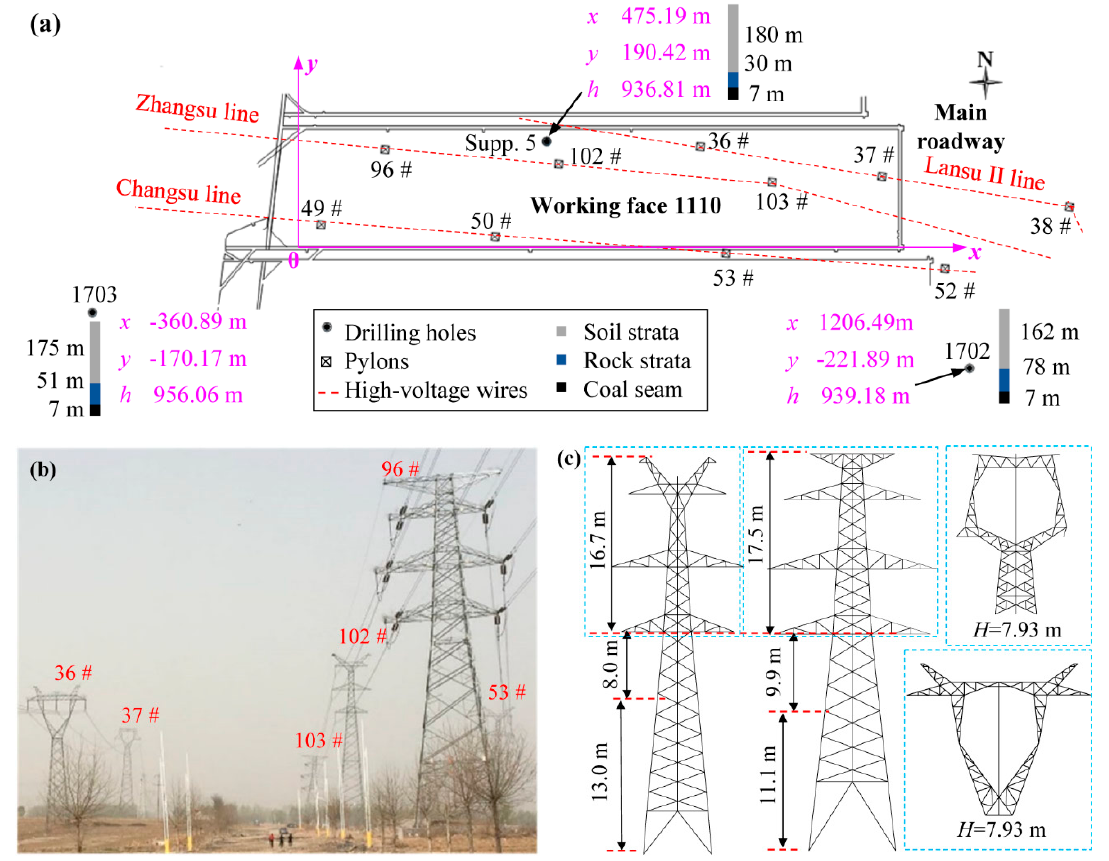
Figure 3. ( a ) Schematic diagram of distributions of high-voltage pylons over working face 1110, ( b ) physical picture and ( c ) geometry of high-voltage pylons. Table 1. Position coordinates of high-voltage pylons over working face 1110. Pylon No.